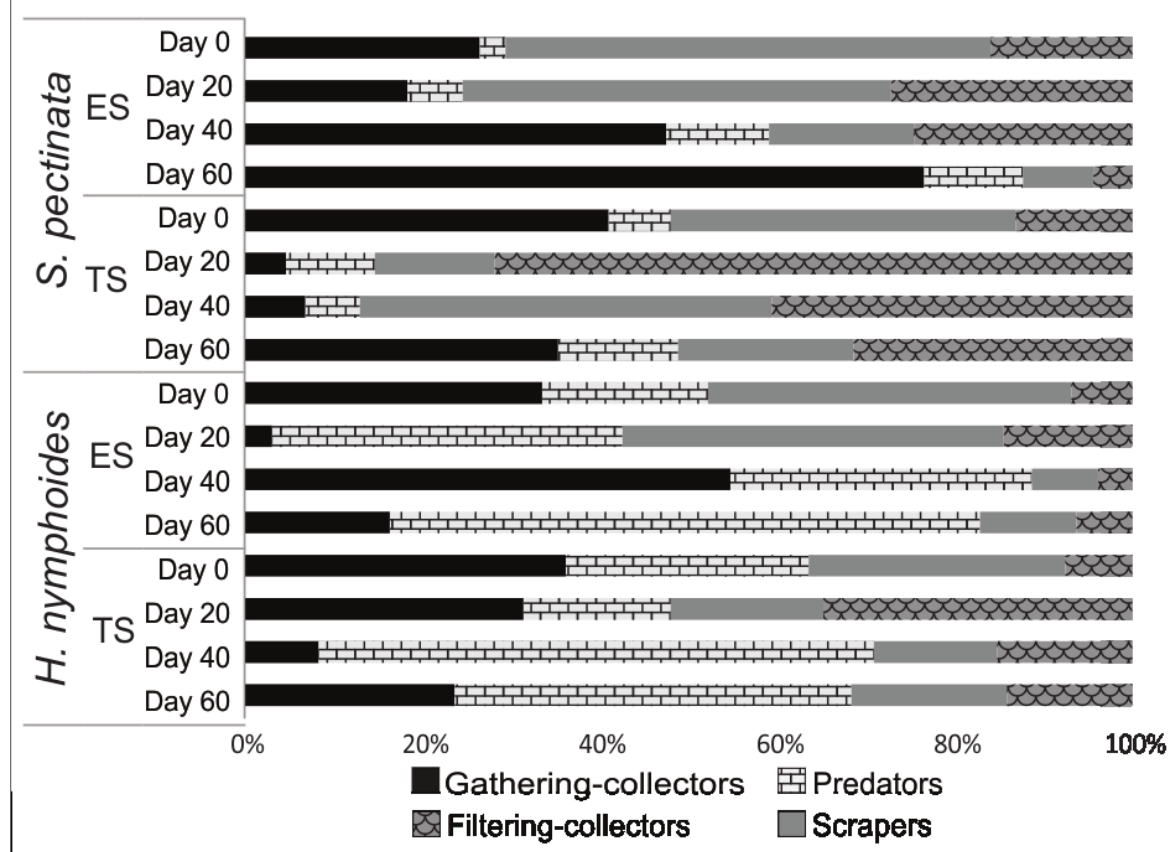
Figure 4. Proportion of functional feeding groups (FFGs) on S. pectinata and H. nymphoides at extraction (ES) and transplant (TS) site for each